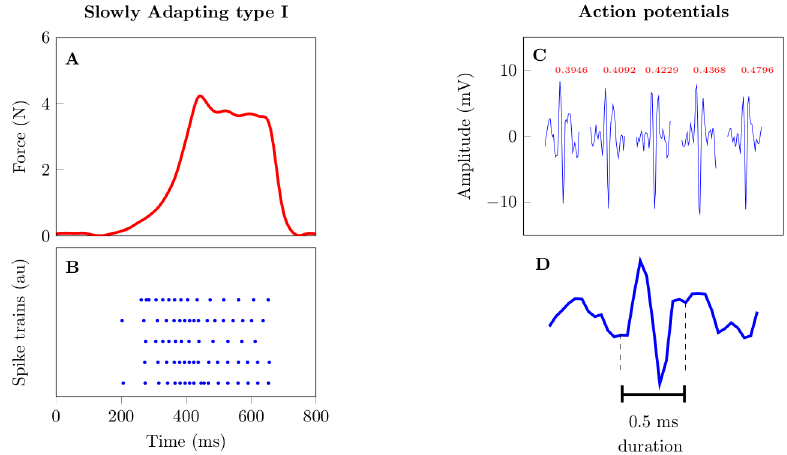
Fig 1. Example of SA-I firing characteristics. Panel A shows the stimulus used to elicit slowly adapting type I tactile response shown in B . Panel C shows a representation of a series of action potentials along with their corresponding times of occurrence (in ms). A zoomed in version of the left most action potential is represented in panel D . We fit a nonhomogeneous Poisson model to the first portion of the data (100 – 450 ms). The inverse problem — decoding — was done using data in the range 451 – 750